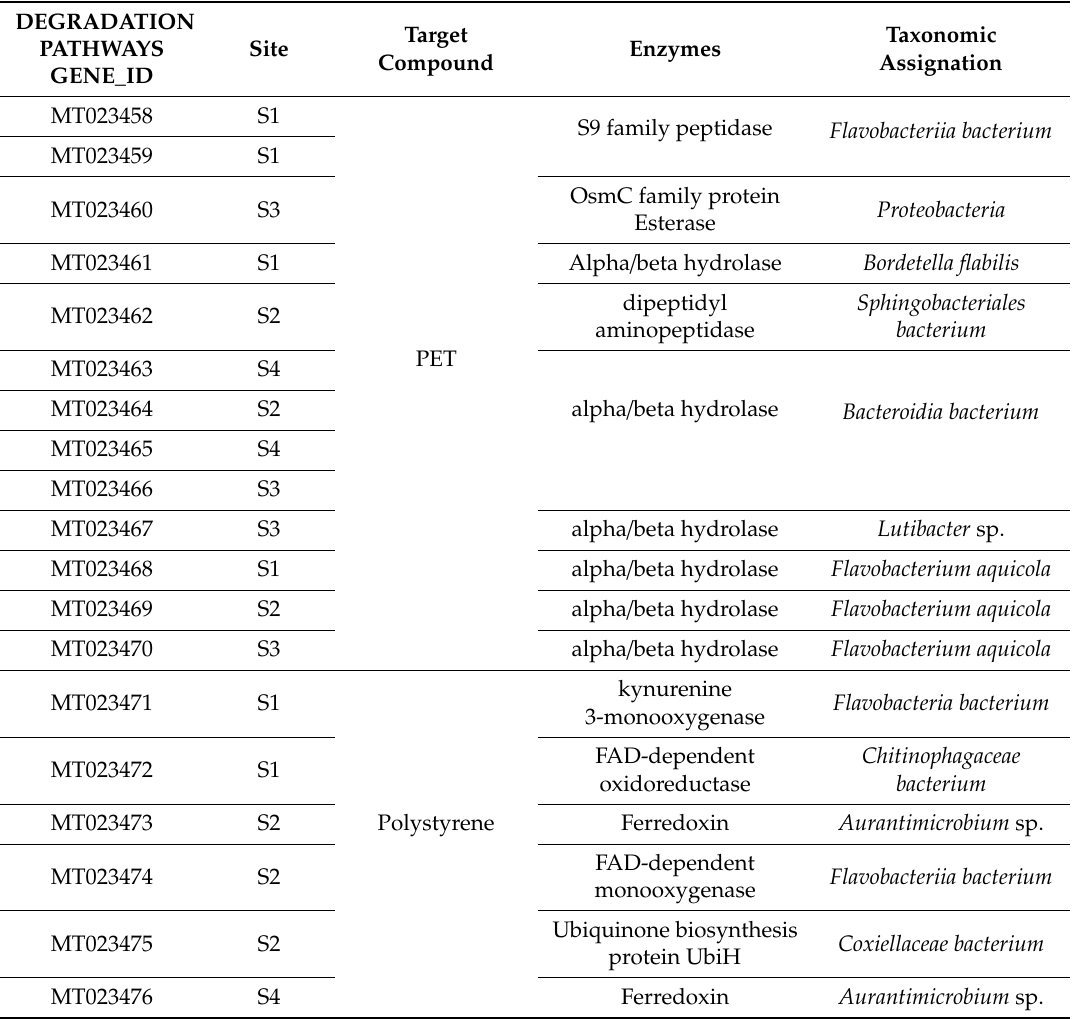
Table 4. Putative genes and enzymes involved in the degradation of PET and Polystyrene in the Apatlaco River’s